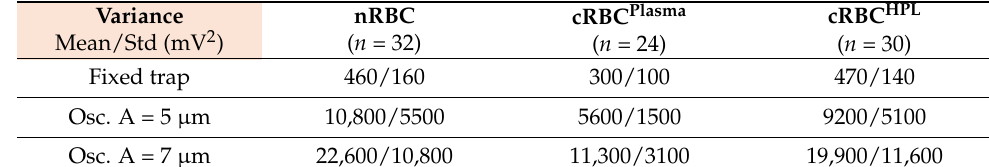
Table 1. Variance for cells in fixed and oscillating traps.